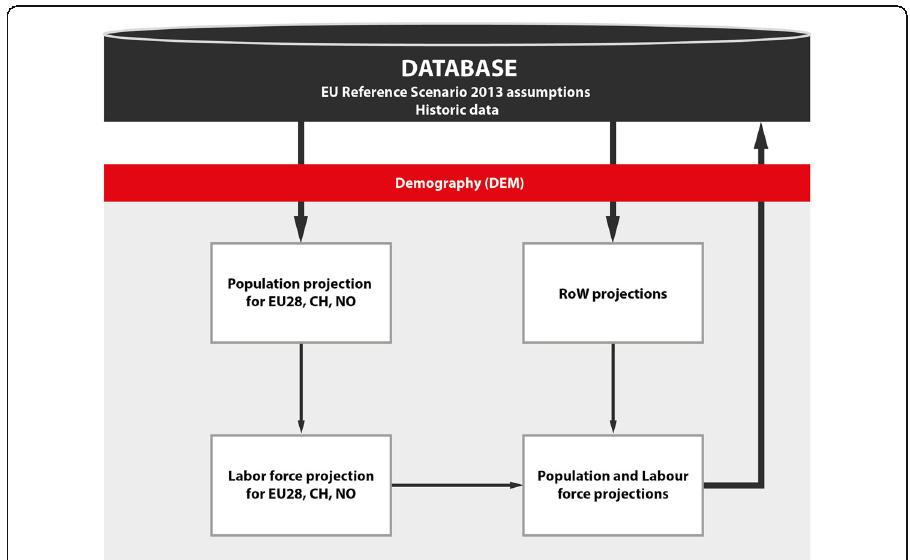
Fig. 2 Structure of the Demography